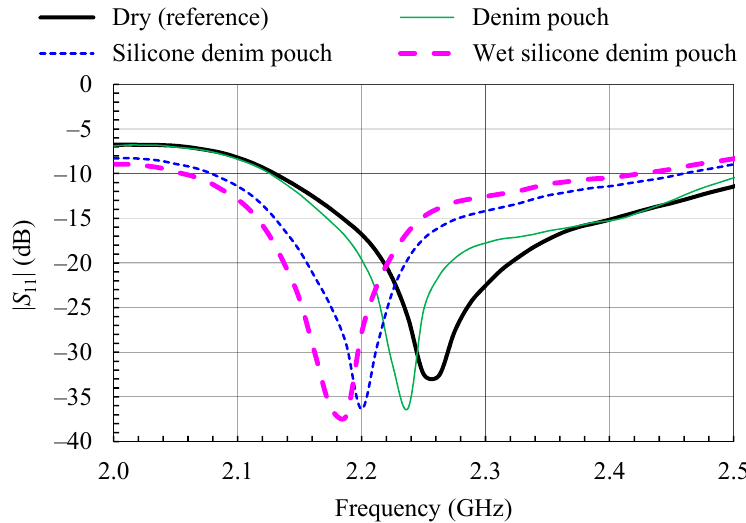
Figure 13. Measured magnitude of the input reflection coefficient of the textile PIFA with protective silicone-sealant-coated denim pouch.